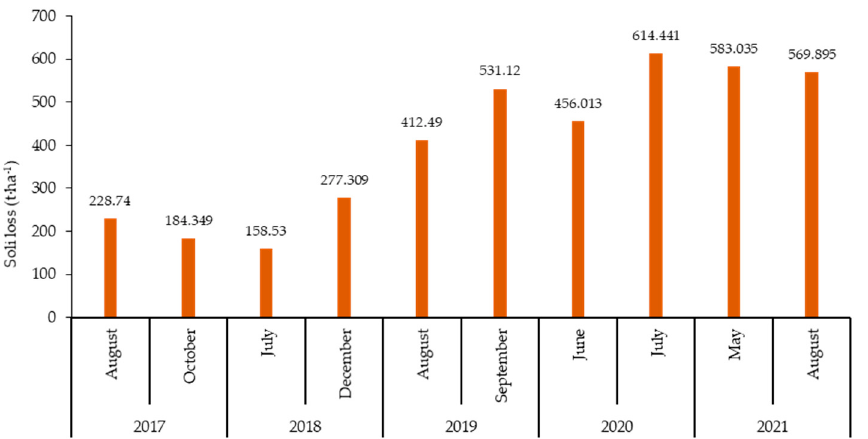
Figure 7. Months of maximum soil loss from 2017 to